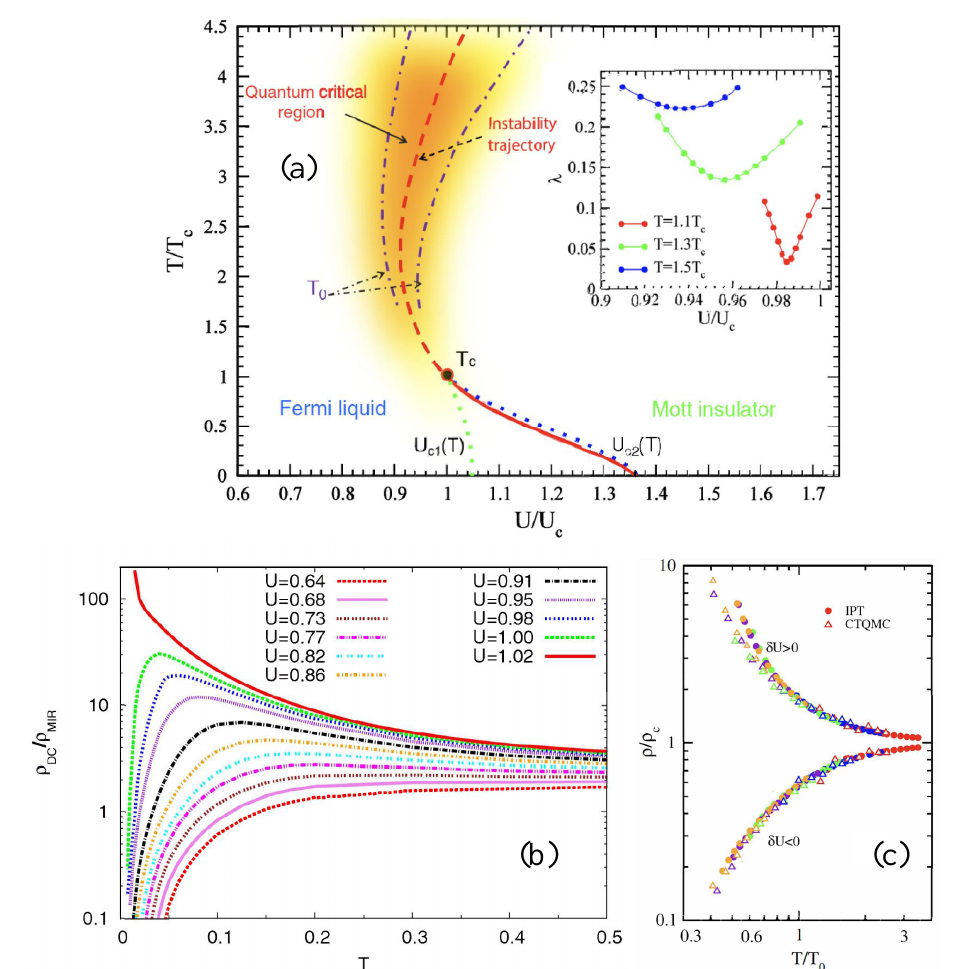
Figure 8. Predictions of DMFT theory. ( a ) Phase diagram featuring a phase coexistence region at T < T c , and a Quantum Critical region centered around the Quantum Widom Line (QWL) (adapted with permission from Ref. [46] Copyright 2011 American Physical Society). ( b ) Resistivity (normalized by the Mott-Ioffe-Regel (MIR) limit) as a function of temperature T across the transition. Note the pronounced resistivity maxima on the metallic side (adapted with permission from Ref. [66] Copyright 2010 American Physical Society. ( c ) scaling collapse of the resistivity curves, displaying pronounced “mirror symmetry” of the two branches (adapted with permission from Ref. [46] Copyright 2011 American Physical